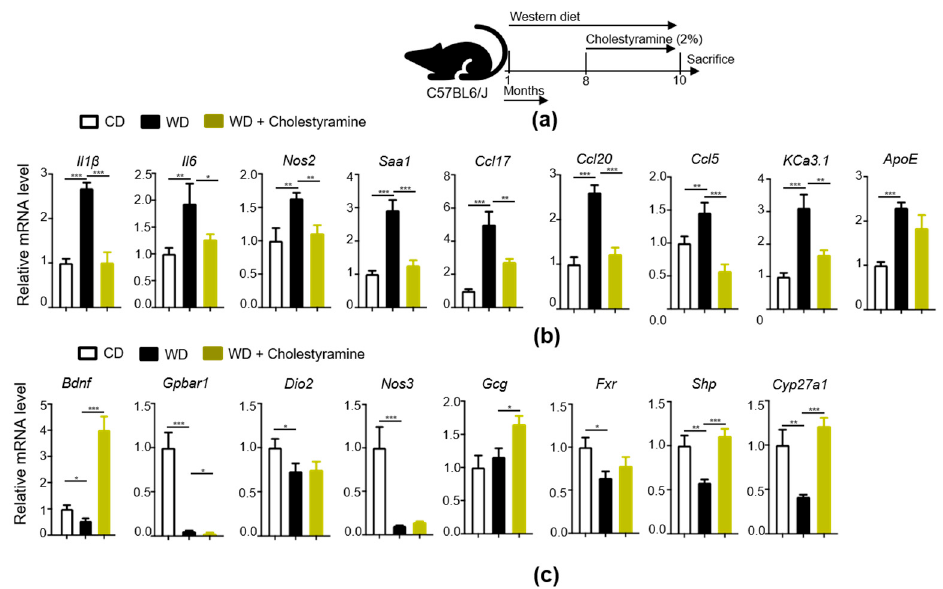
Figure 7. Effect of bile acid depletion by cholestyramine on brain inflammation and bile acid receptor signaling: ( a ) Experimental schema; ( b ) Relative mRNA level of inflammatory signaling genes in the brain (CD, n = 6; WD, n = 6; WD + cholestyramine n = 4); ( c ) Relative mRNA level of bile acid receptor signaling genes in the brain of all experimental groups. Data are expressed as mean ± SD. * p < 0.05, ** p < 0.01, *** p < 0.001, CD-fed compared with WD-fed mice, WD-fed mice compared with cholestyramine treated mice.